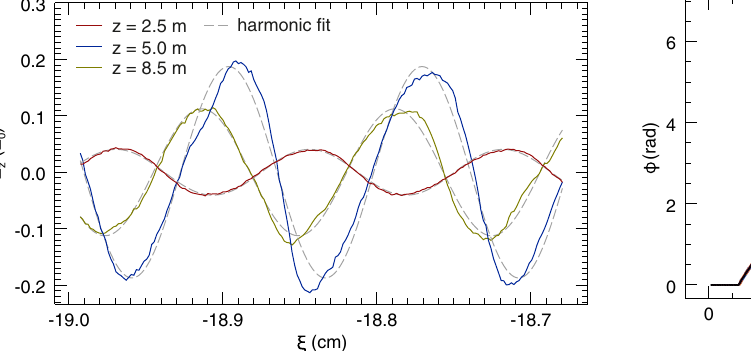
FIG. 5. Examples of the harmonic fit to a segment of E z located around ξ ≈ − 1 . 5 σ zb at three different positions along the plasma. The solid lines correspond to the data (smoothed) and the dashed lines to the fits.